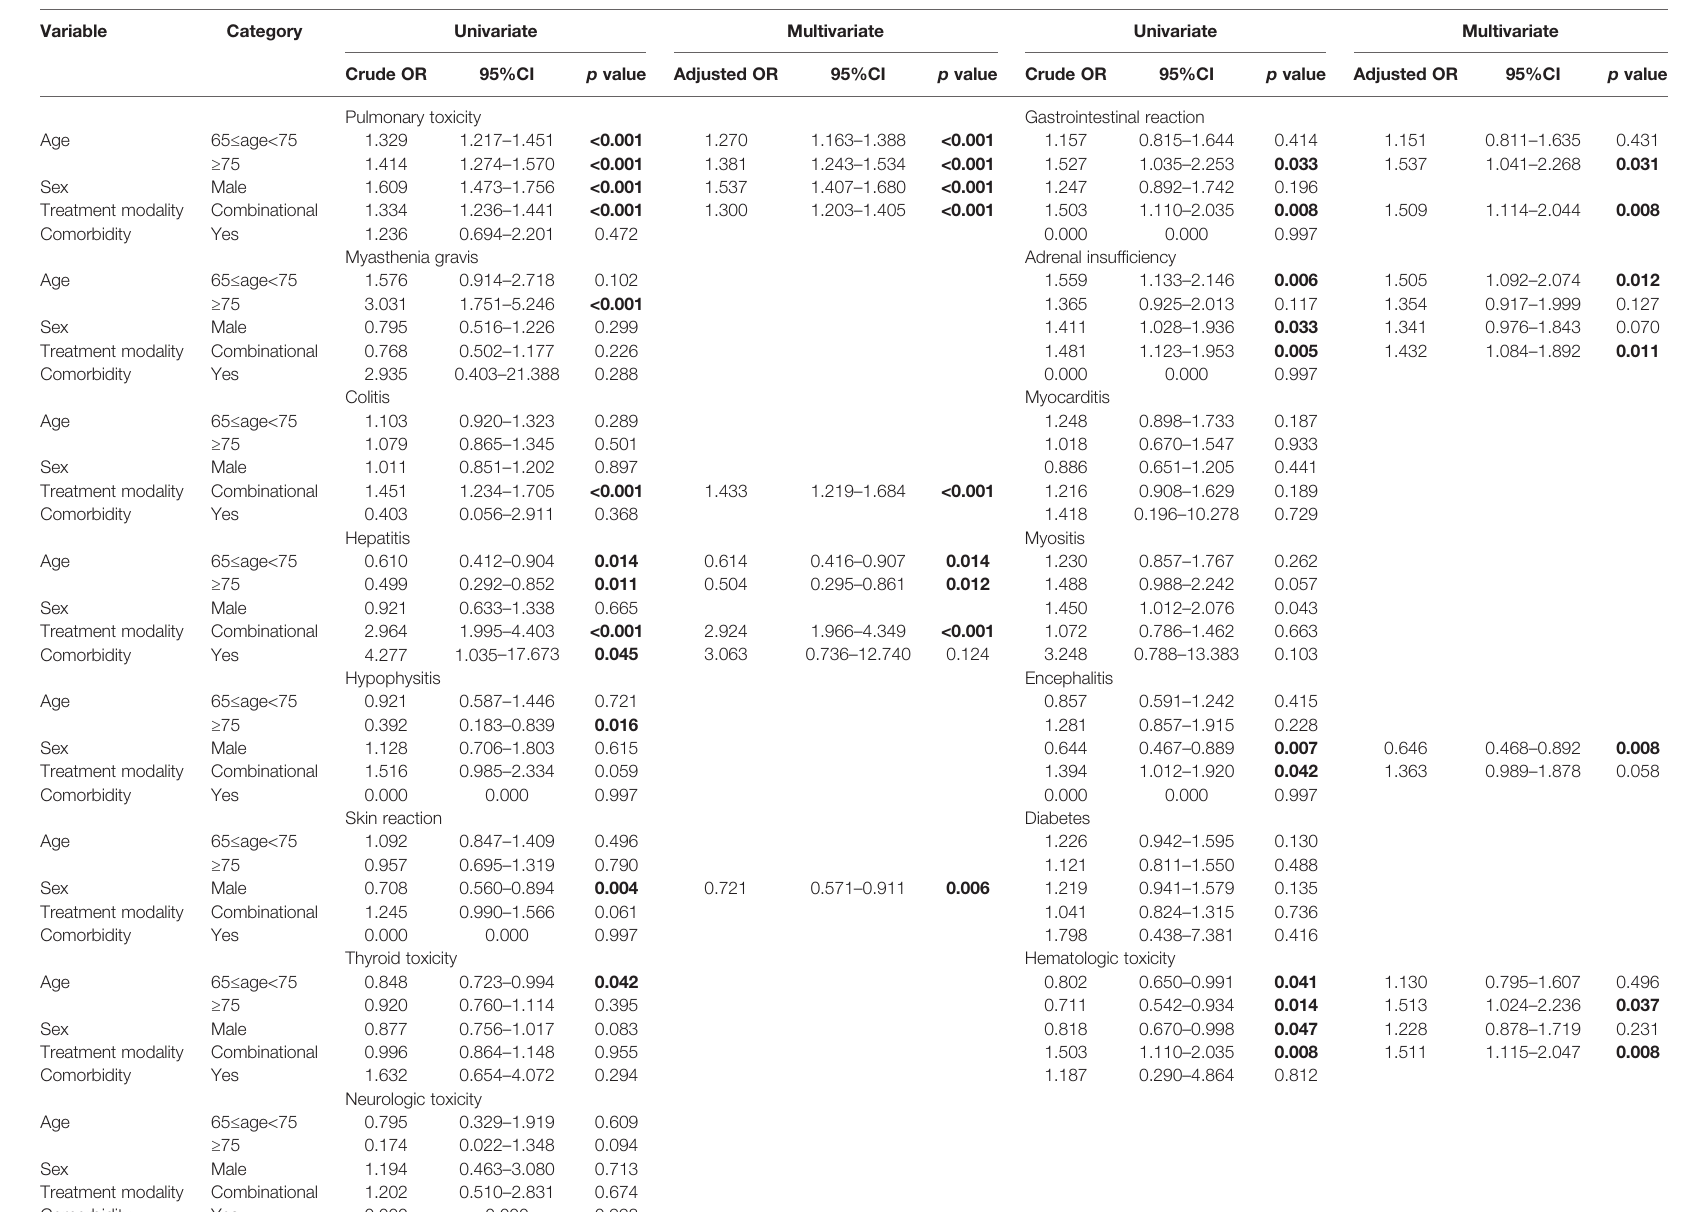
TABLE 2 | Univariate and multivariate logistic regression analysis of the odds ratio for different irAEs, controlling for multiple